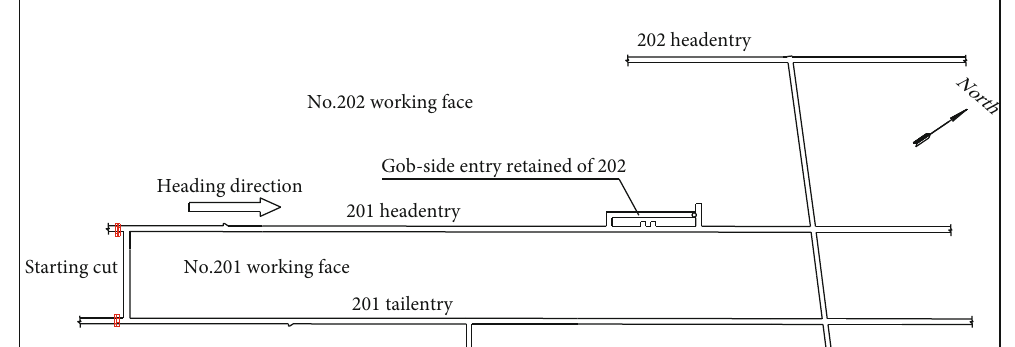
Figure 3: Schematic diagram of 202 gob-side entry retained test section.